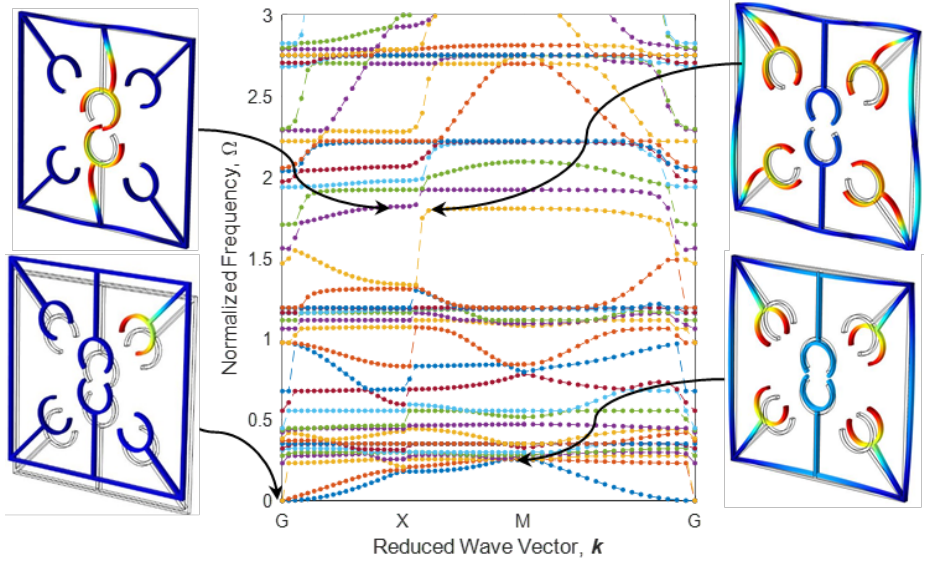
Figure 15. The counterpart of Figure 12 for 70 mm/s.